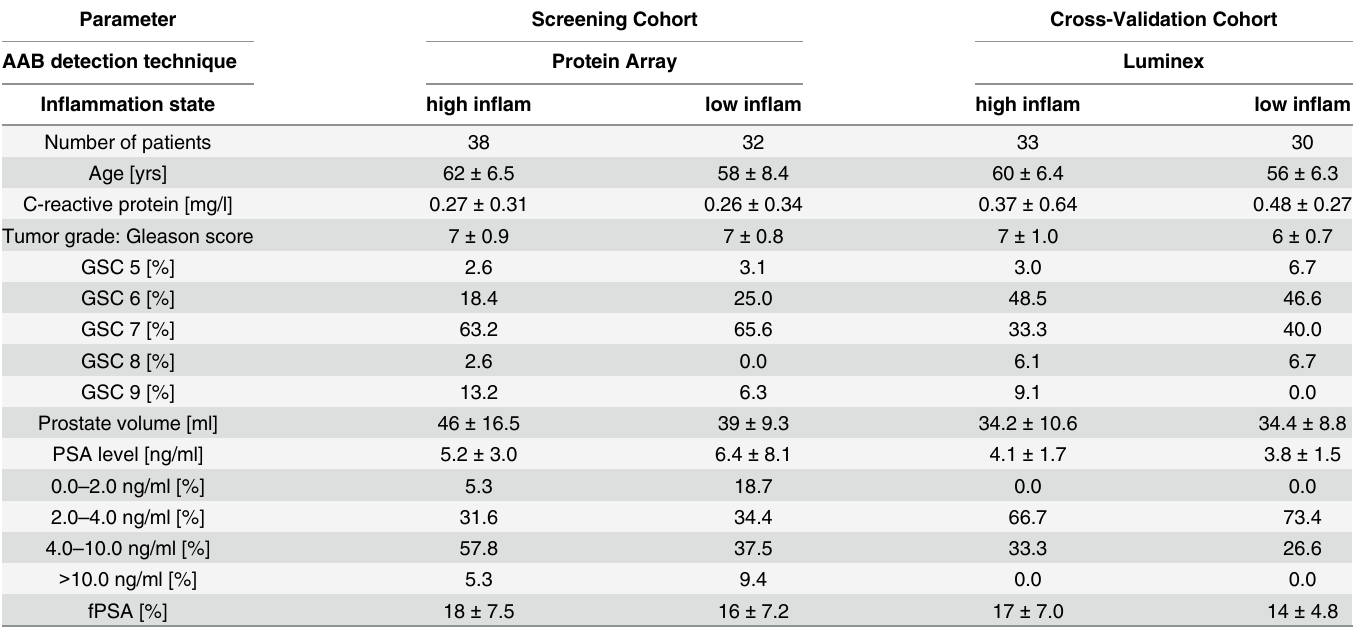
Table 1. Clinical and pathological cohort